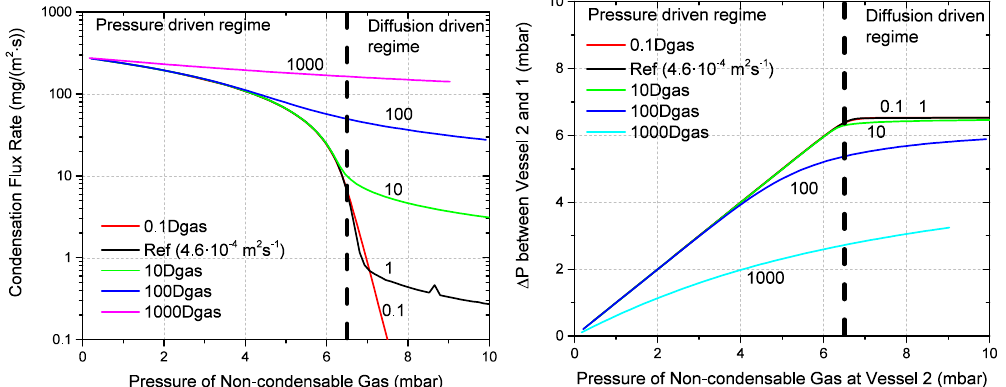
Figure 17. Effects of the NCG diffusion coefficients on the condensation flux ( a ) and pressure difference ( b ) as a function of pressures of non-condensable gas at the condensation surface of vessel